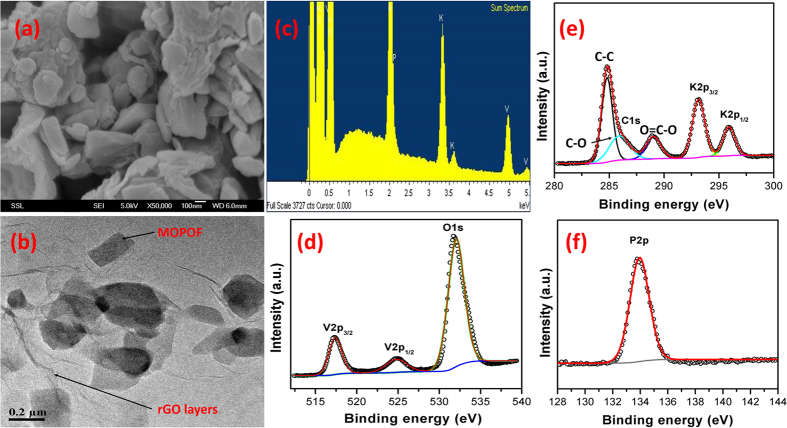
Morphology and composition.(a) FESEM image of rGO/K2[(VO)2(HPO4)2(C2O4)]∙4.5H2O composite (scale: 100 nm, mag: 50000), (b) TEM image of the composite showing the MOPOF nanoplates embedded in rGO layers (scale: 200 nm); (c) EDX spectra of K2[(VO)2(HPO4)2(C2O4)]∙4.5H2O and (d–f) XPS spectra of individual elements in K2[(VO)2(HPO4)2(C2O4)]∙4.5H2O; (d) O1s, V2p; (e) K2p, C1s and (f) P2p.